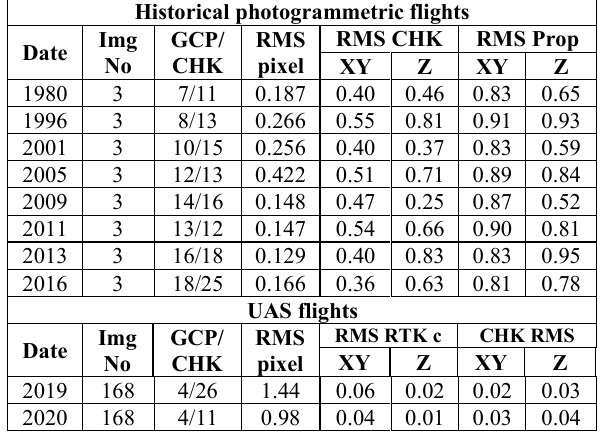
Table 2. Orientation processing data and errors (in